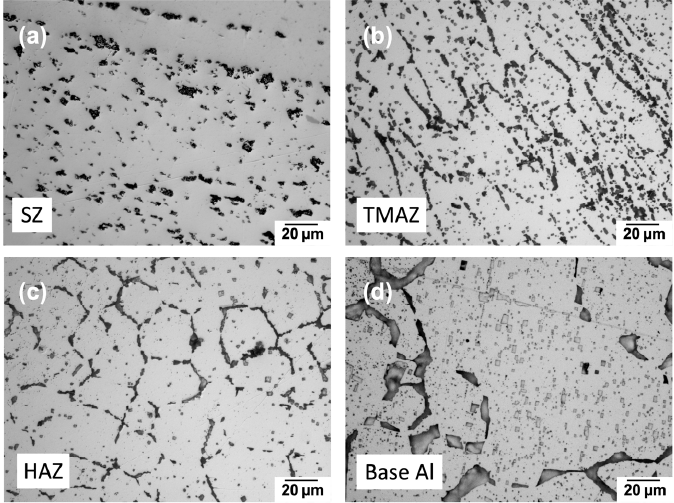
Figure 5. Optical microscopic pictures of a grain structure on etched 6022 Al from a cross-sectional perspective: ( a ) Stirred zone; ( b ) thermomechanically affected zone; ( c ) heat-affected zone; ( d ) base 6022 Al.